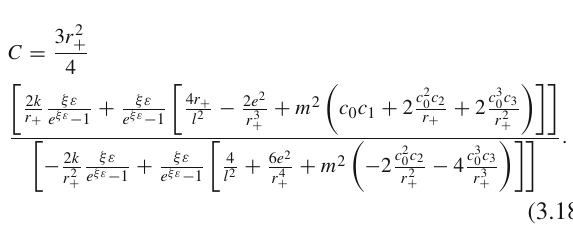
The specific heat is given